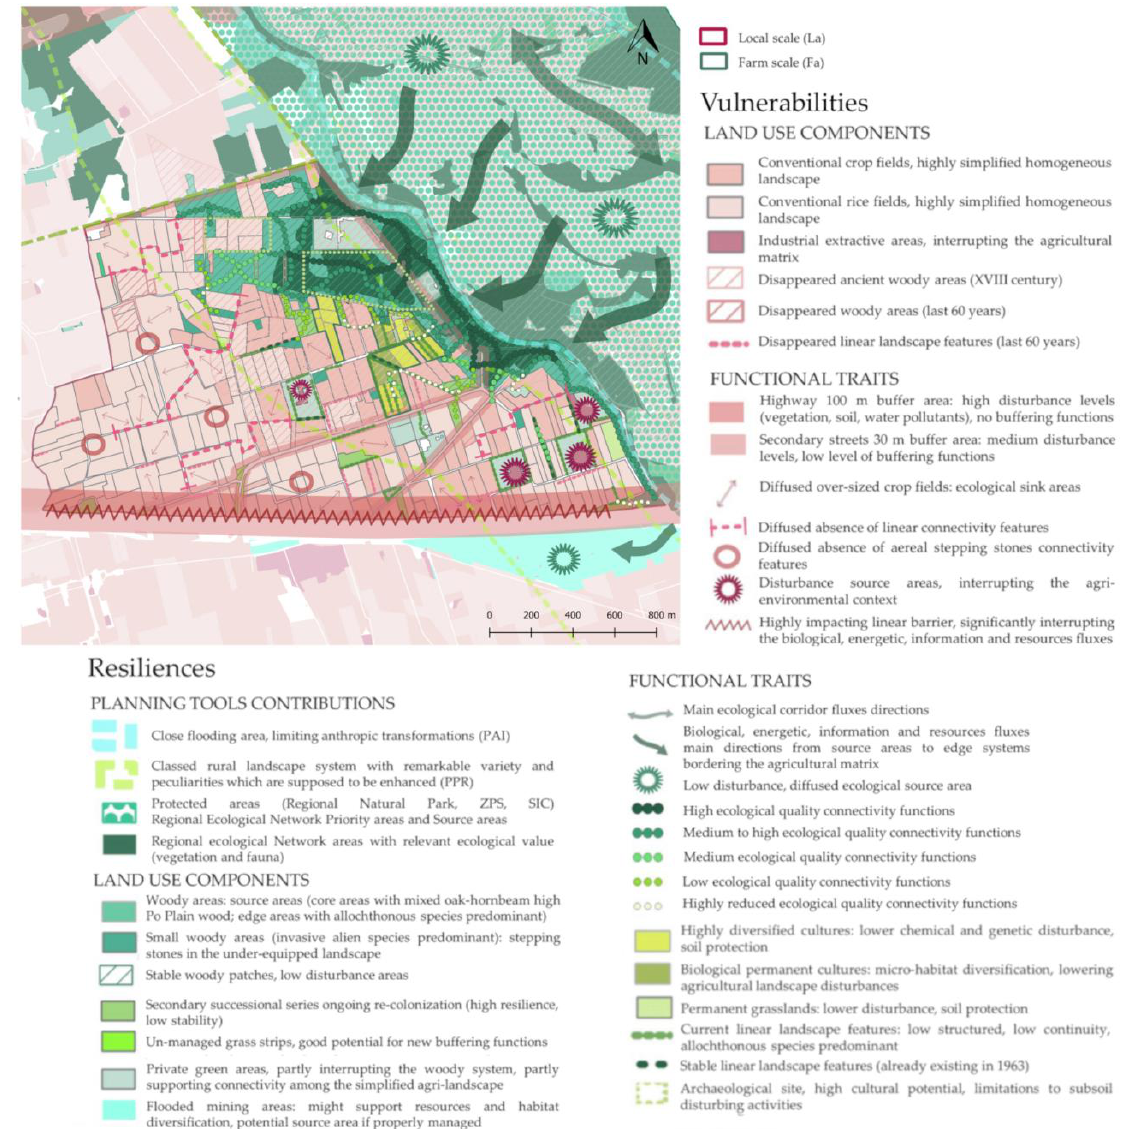
Figure 7. Local scale VR analysis.